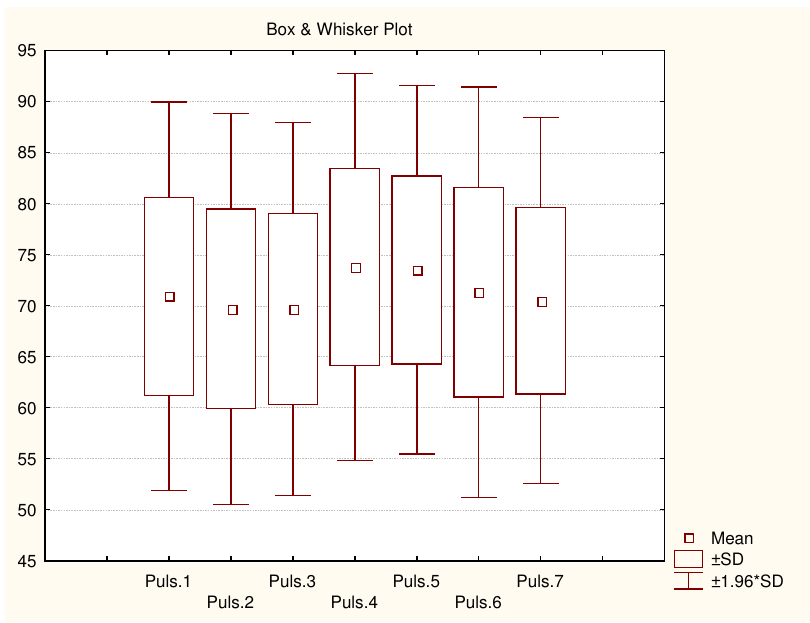
Fig 6. Variation in heart